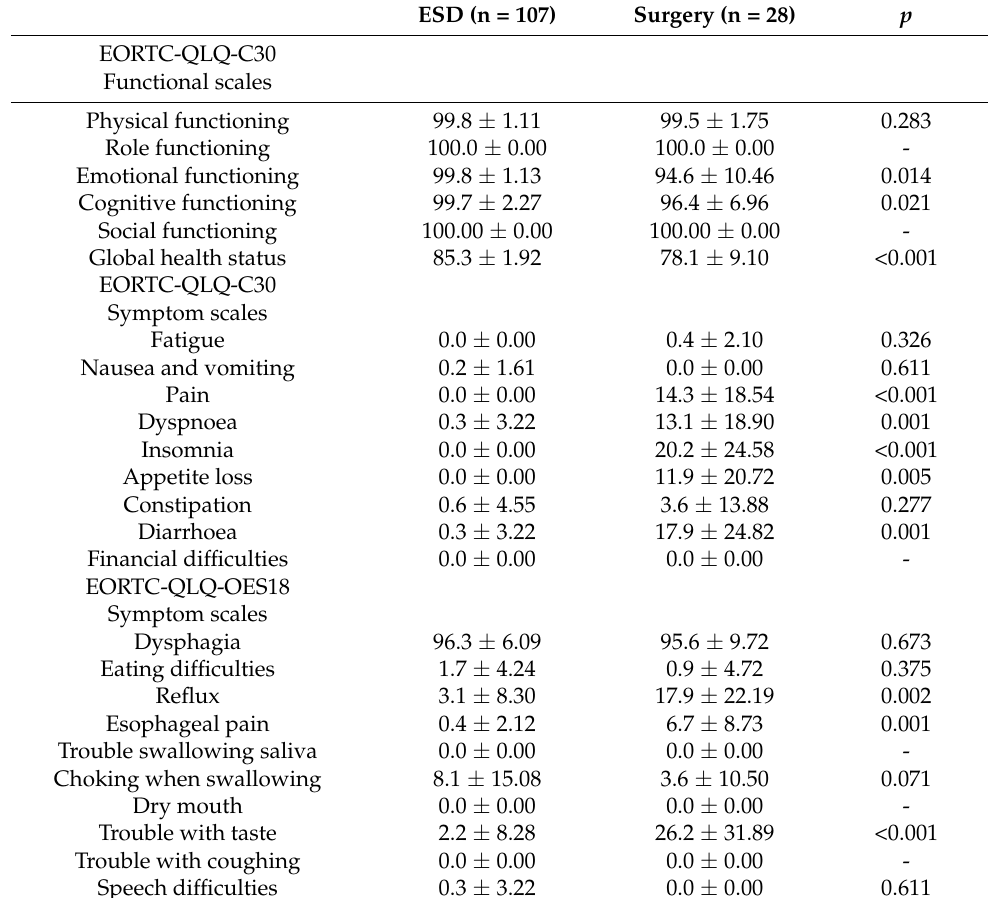
EORTC, European Organization for Research and Treatment of Cancer; QLQ-C30, Quality of Life Questionnaire- Core 30; QLQ-OES18, Quality of Life Questionnaire-OES18; SD, standard deviation. 3.7. The Effect of Different Methods to Prevent Esophageal Stenosis after ESD We categorized patients into five groups according to different interventions to prevent esophageal stenosis, such as repeated EBD, PGA with AEM, PGA with TSI, PGA with AEM transplantation and TSI, and PGA with AEM transplantation and SSWB (Figure 3). PGA with AEM and TSI reduced the mean number of balloon dilatations from 10.8 ± 8.28 (only